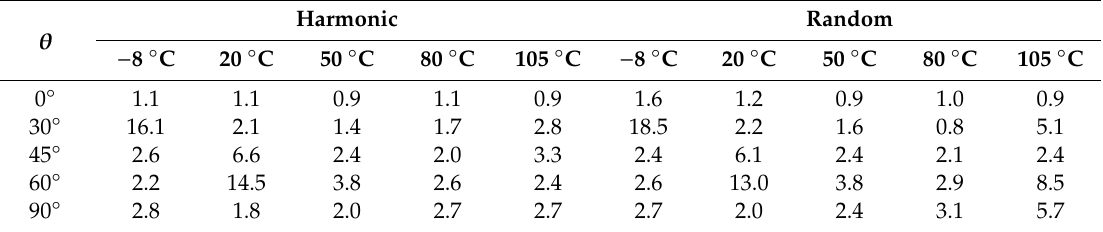
Table 5. Variation of damping coe ffi cient ( ξ 1 ) according to di ff erent parameter conditions.